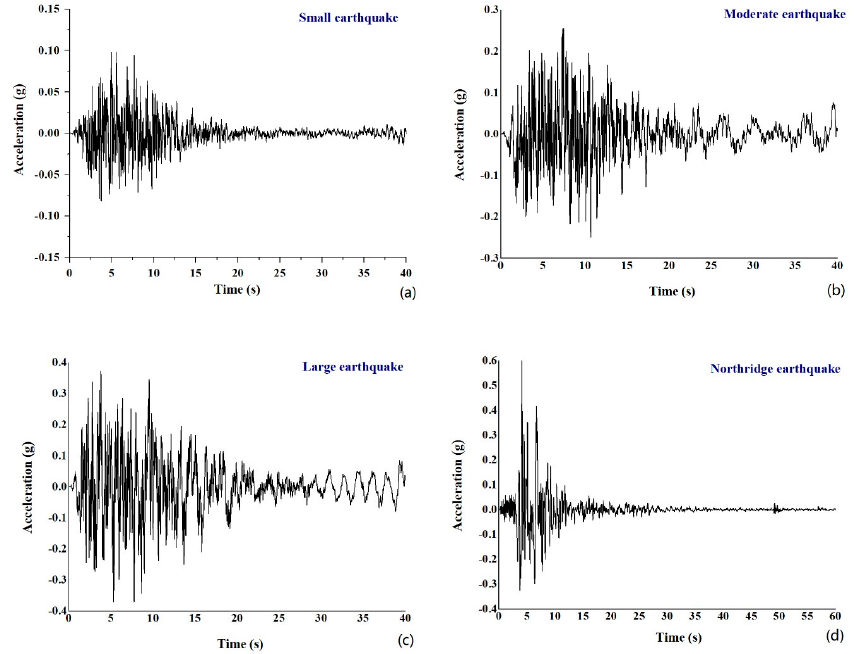
Figure 5. Time history of earthquakes: ( a ) small earthquake, ( b ) moderate earthquake, ( c ) large earthquake, and ( d ) Northridge earthquake.